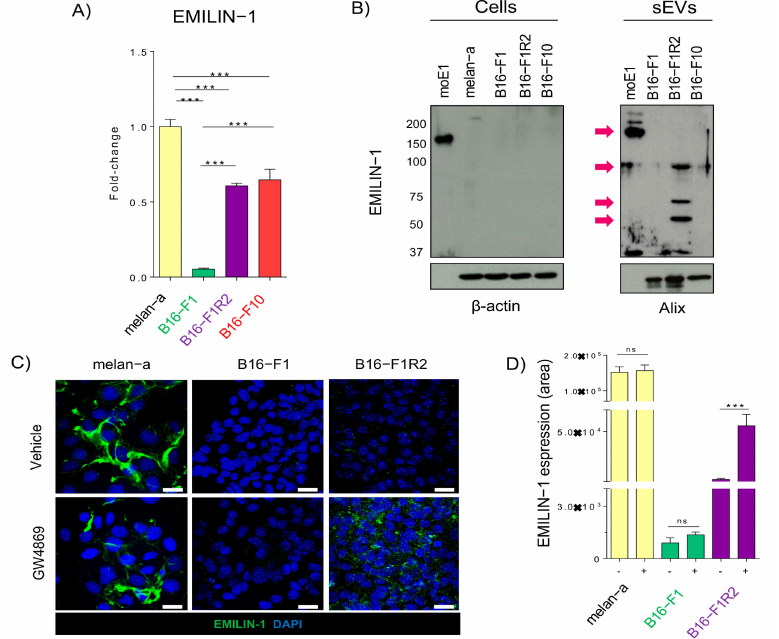
Figure 2. EMILIN-1 is degraded and secreted in sEVs from B16-F1R2 cell line. ( A ) mRNA expression levels by qRT-PCR of EMILIN-1 ( n = 2), *** p < 0.001 using Mann Whitney test. ( B ) Analysis by Western-blot of EMILIN-1 in mouse cell line models and derived sEVs (B16-F1, B16-F1R2, and B16- F10). moE1, EMILIN-1 recombinant mouse protein, was used as loading positive control, molecular weight expected is 150 kDa indicated by an arrow. Anti-EMILIN-1 antibody detected several bands with a lower molecular weight than expected in secreted sEVs, indicated by an arrow. ( C ) Analysis of EMILIN-1 (in green) expression and localization by confocal immunofluorescence (scale 18 µ m) in melanocytes, B16-F1 and B16-F1R2 cell lines before and after the treatment with 10 µ M GW4869 during 24 h. Cell nuclei were stained with DAPI (in blue). ( D ) Quantification of EMILIN-1 expression (green signal) in ( C ), *** p < 0.001, ns: non-significant, by Non-parametric t